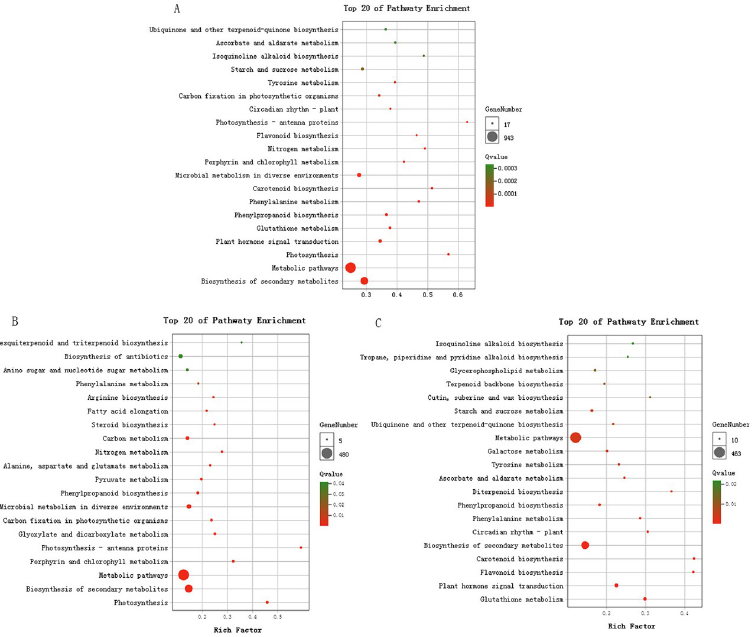
Fig 4. KEGG pathway enrichment of Differentially Expressed Genes (DEGs) in Pennisetum setaceum ‘Rubrum’. (A) All DEGs enriched in KEGG pathways; (B) Pathway enrichment of upregulated DEGs; (C) Pathway enrichment of downregulated